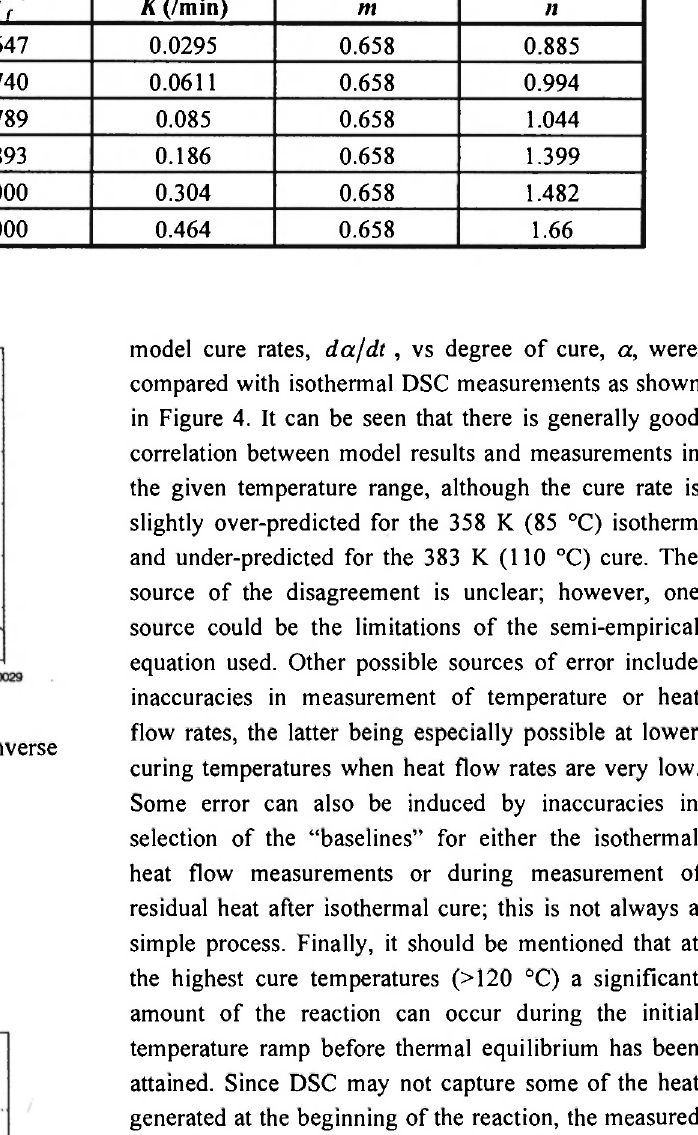
Fig. 2: The parameter A" as a function of inverse absolute temperature